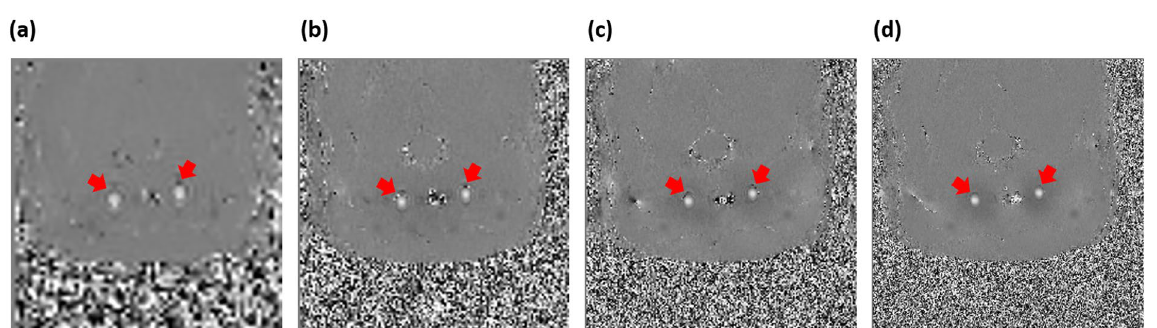
Figure 3. Phase images from a representative rat CCA with in-plane resolution of ( a ) 0.63 mm, ( b ) 0.31 mm, ( c ) 0.21 mm, and ( d ) 0.16 mm. Red arrows indicate the locations of